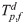
(a) Distribution of node-pedestrian degree per day as a percentage of the total number of passengers. The degree of a node counts the number of people encountered with a mutual distance smaller than 1.5m (hence, degree 0 means that a person did not have any Corona event). We observe that high-degree nodes, i.e. repeated distance offenders, increased steadily until the train schedule change (e.g. nodes with 10+ contacts grew from ≈1% to ≈10%). The schedule change yielded a temporary drop in the offender percentage after which it started increasing again. This can be a sign of warning towards the relaxation in the compliance of physical distancing rules. (b) Probability density function of the individual exposure time discounted of families, Tp,fd considering different maximum distances (Eq (9)). Exposure times show a power-law behavior. The PDF depletion after T = 5minutes is most likely due to the time windowing that we operate around each train arrival (cf. Fig 4b). This yields a data cut-off for large times.